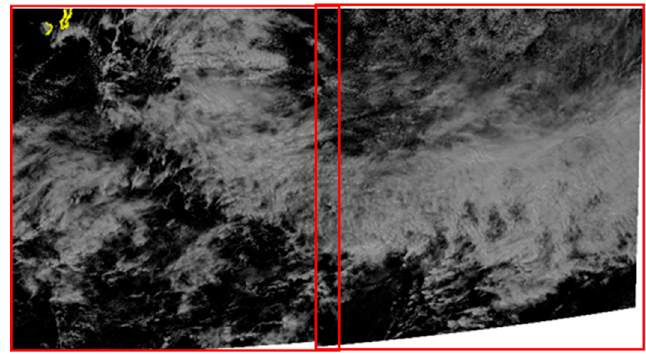
Figure 15. Boundary check between slots 15-14 ( top ), 14-13 ( middle ), and 13-12 ( bottom ).